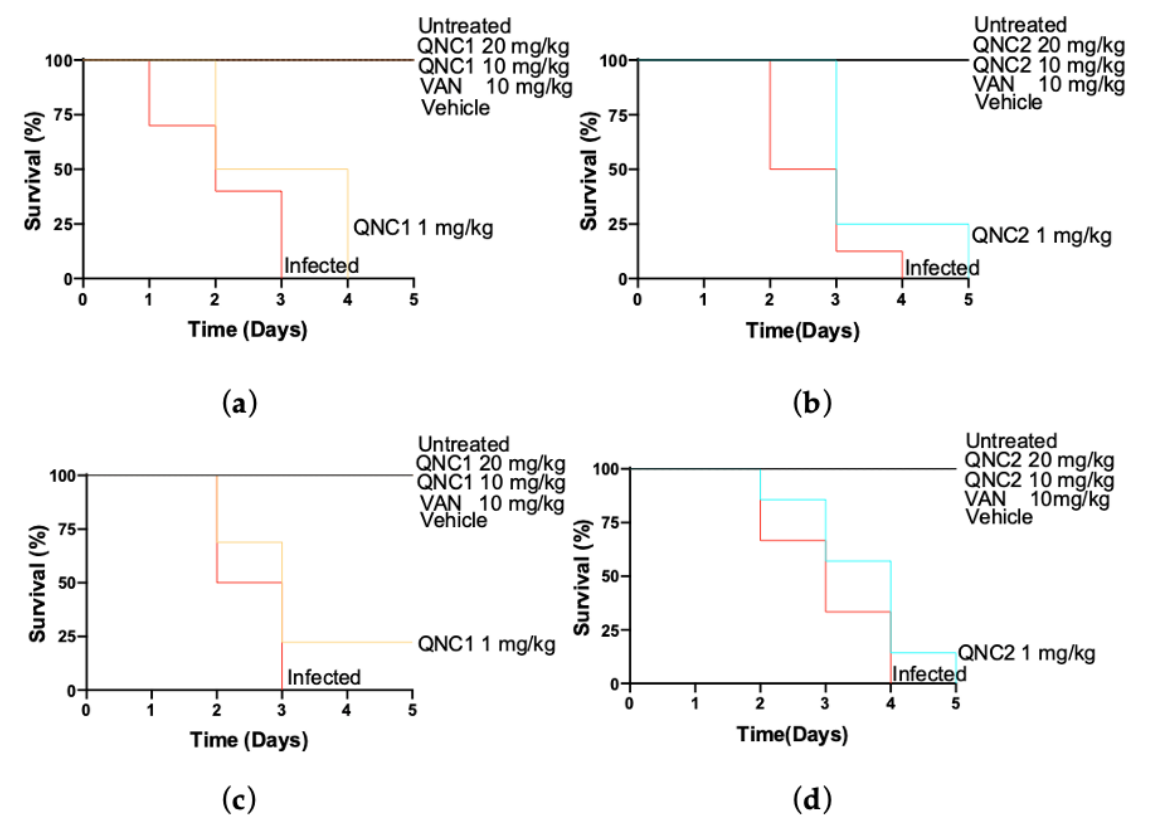
Figure 4. Effects of drug treatment on G. mellonella larvae survival inoculated with MRSA ATCC 29213 ( a , b ) or MRSA ISP- 213 ( c , d ), then QNC1( a , c ) or QNC2 ( b , d ) at 1, 10 and 20 mg/kg were administered at 0 Days (i.e., 1 hour after inoculation). Vancomycin (1 mg/kg) was used as control.